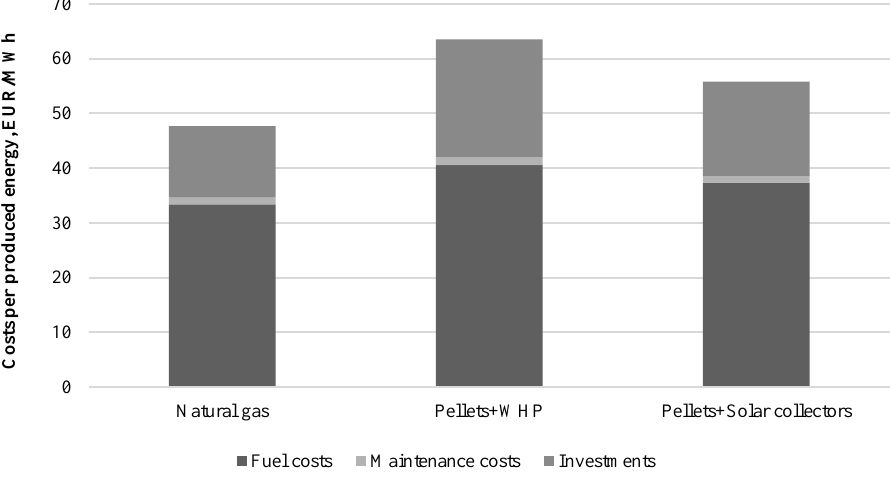
Fig. 2. Calculated costs per energy